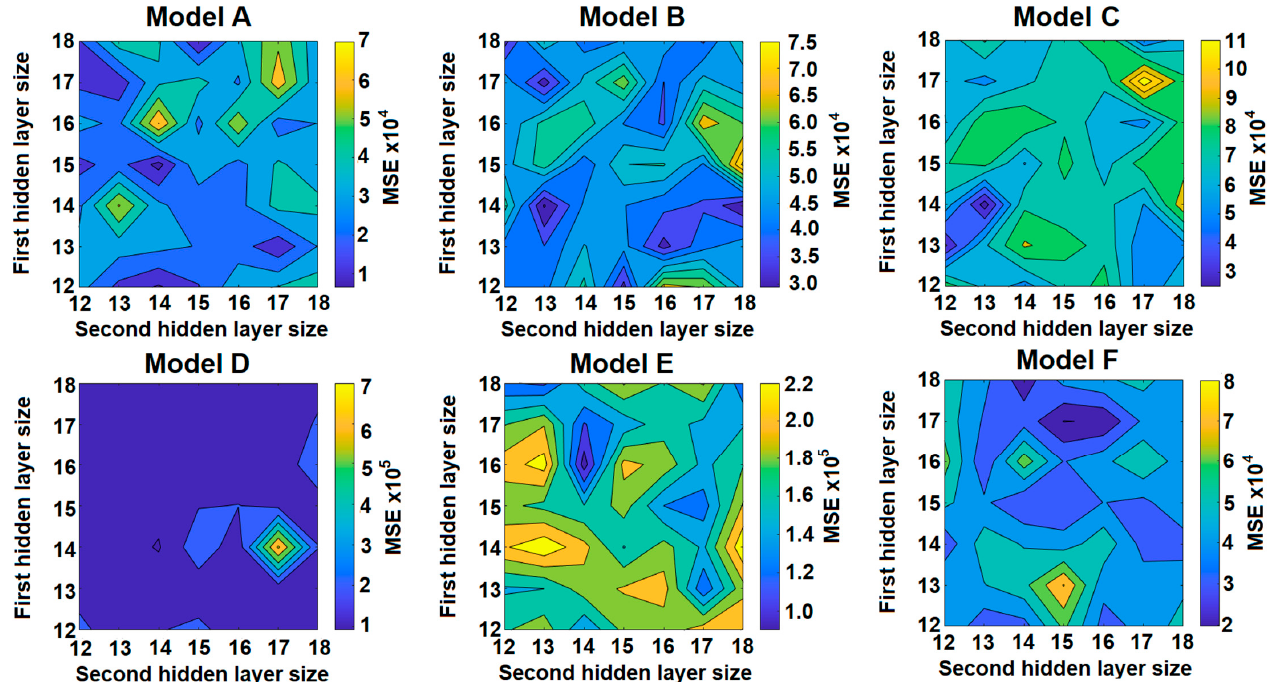
Figure 11. ANN with best results (lower MSE value) in each combination of the size of hidden layers, changing the training method and training cycles. The figure shows the lowest MSE obtained in models A to F for each association between the number of neurons in the first and second hidden layers.